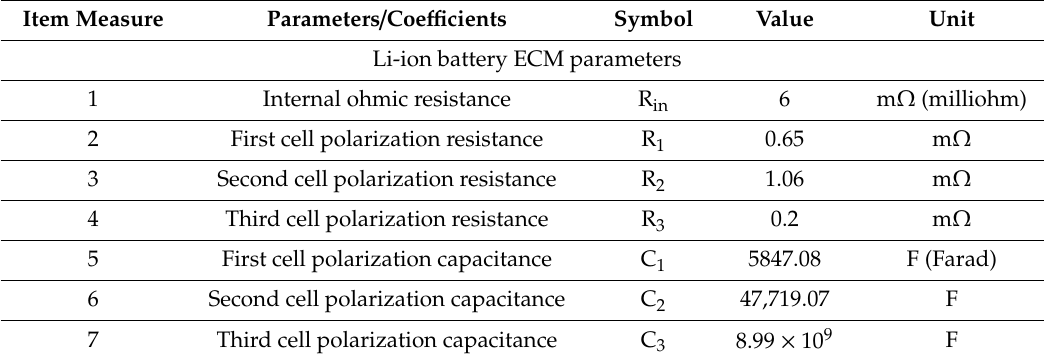
Table 3. The RC ECM parameters [17–23].